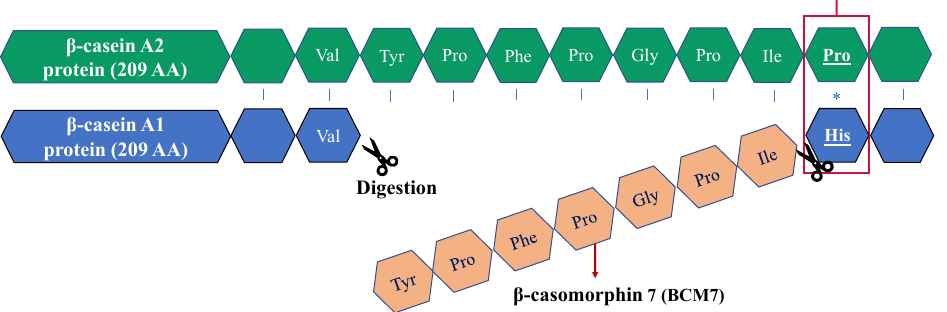
Figure 1. Schematic view of the partial amino acid sequences of the β -casein A2- and A1 protein. The red box and asterisk indicate the point mutation at position 67 (His in β -casein A1 instead of Pro in β -casein A2). The product of the gastrointestinal digestion of β -casein A1 is called β -casomorphin 7 (BCM-7) depicted in orange.